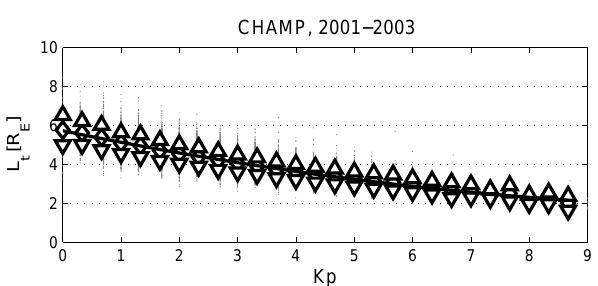
Fig. 6. Dependence of the correlation between L t and the Kp index on (a) the time lag between L t and Kp, and (b) on the reference level chosen for S ∗ .